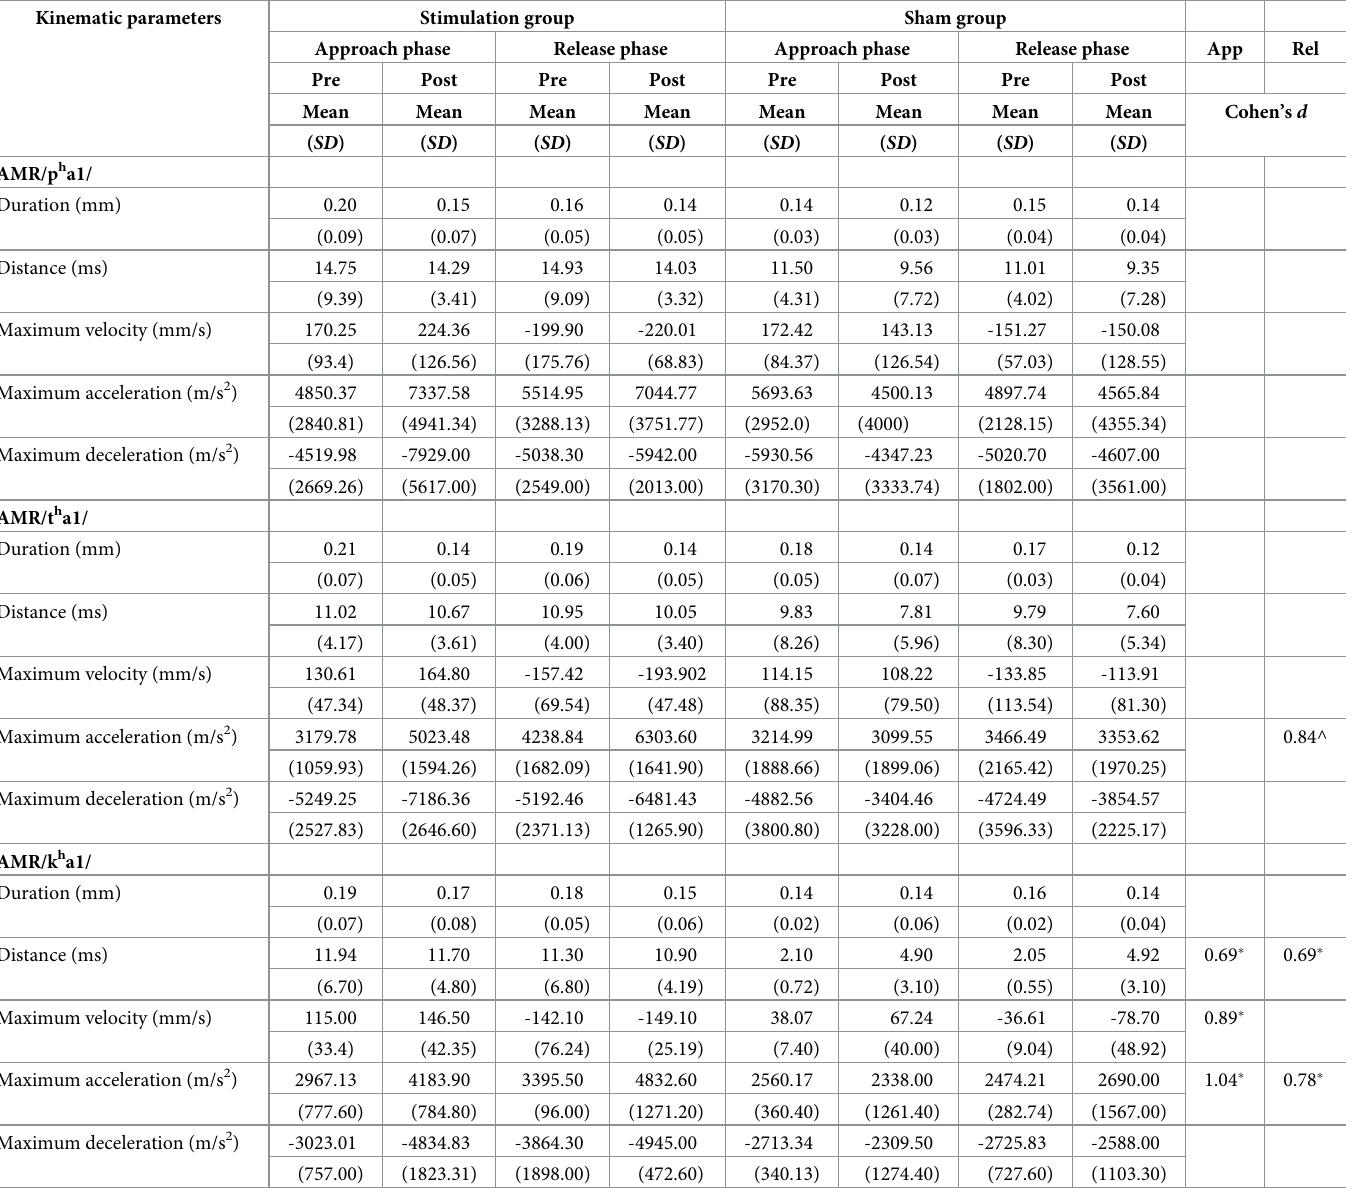
Table 5. Comparison of kinematic parameters (DDK) between the stimulation and sham groups before and after treatment. Kinematic